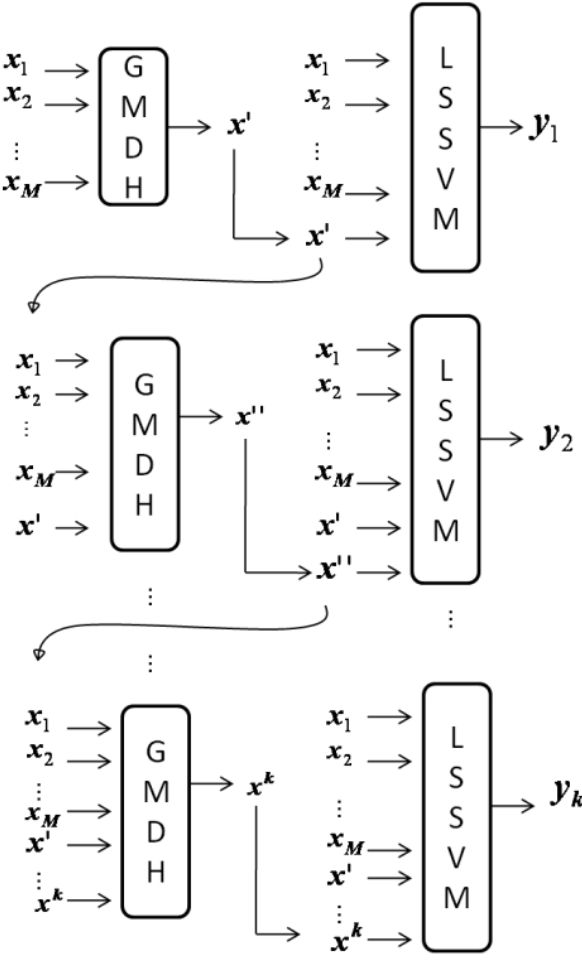
Fig. 4. The structure of the GLSSVM 2